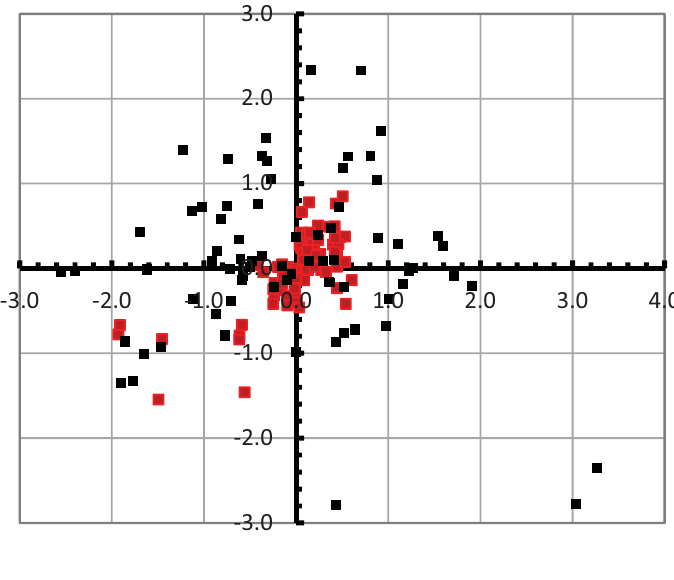
Figure 5. The dispersion of the corners of the B section (in millimiter). The coordinates are relative to the centroid (0, 0). The Wide Mode corners are in black, and the Macro Mode corners are in